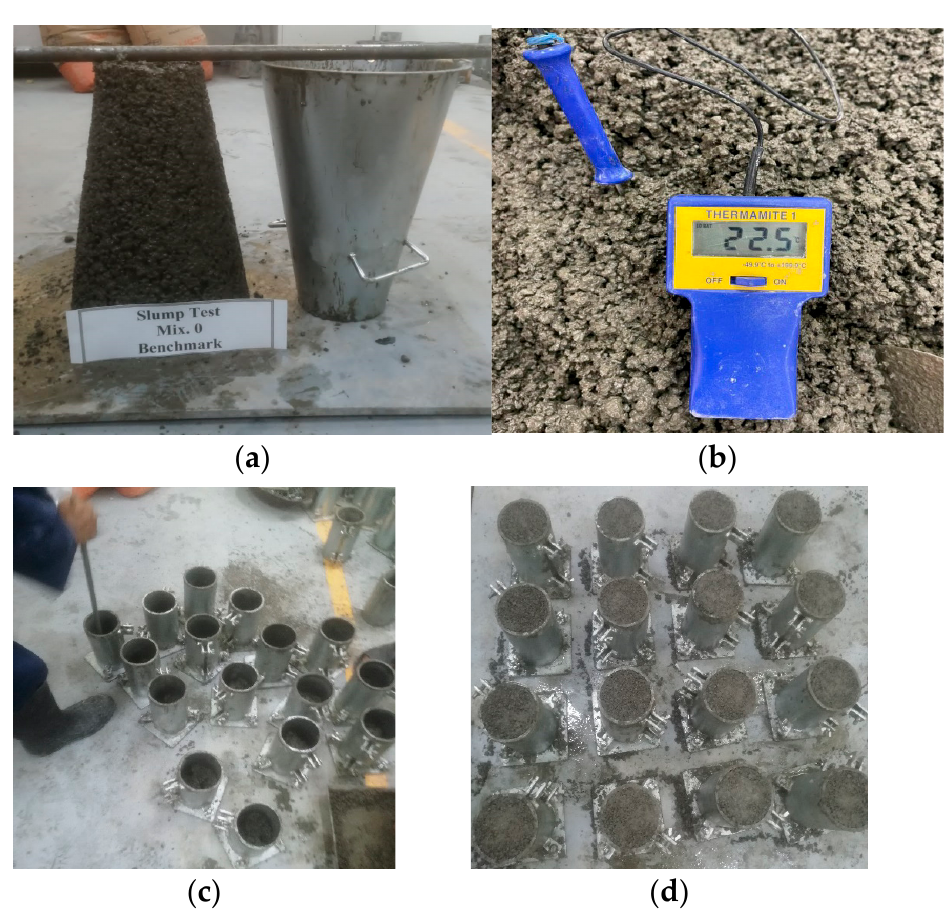
Figure 4. Concrete paste samples: ( a ) slump test; ( b ) temperature measurement; ( c ) partial mold filling and compaction; and ( d ) complete mold filling and surface flattening.